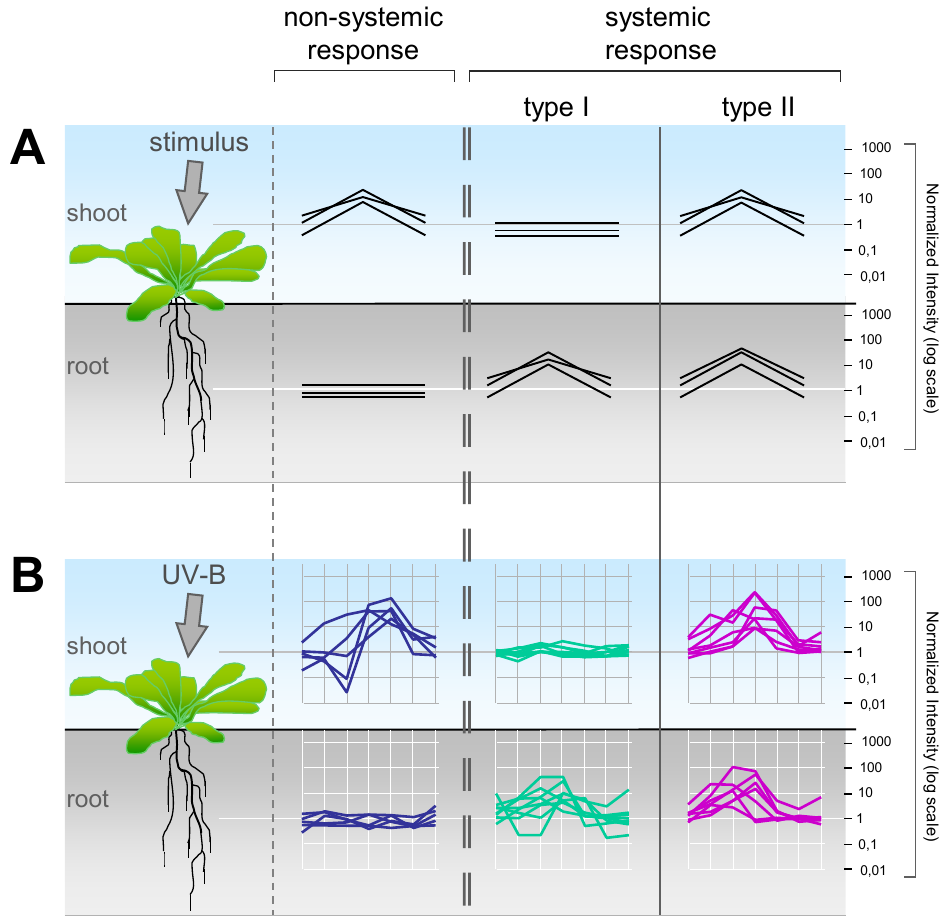
Figure 1. ( A ) Model of the three different gene expression response types in the shoot and root after a stress stimulus; ( B ) Example of non-systemic gene expression trajectories after UV-B irradiation of the shoot, the type I systemic response in the root or the type II systemic response in both tissues. Gene expression changes represent signal intensities normalized to the median and the control